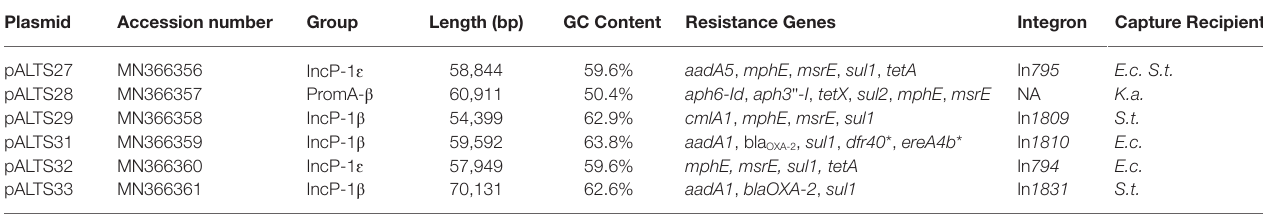
TABLE 2 | Summary of captured plasmids and their antibiotic resistance genes (ARG).